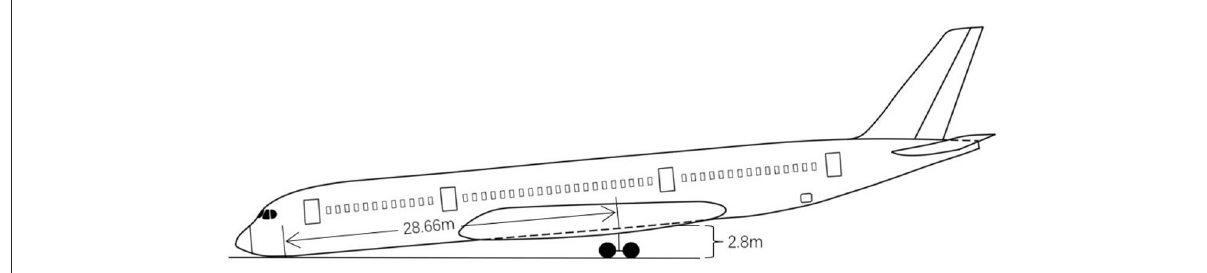
FIGURE9 Schematic diagram of the passenger aircraft in a forward-tilted state.